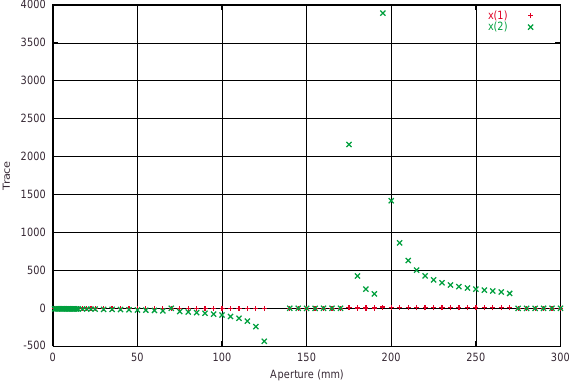
FIG. 3. (Color) First-order and second-order x chromaticities as a function of aperture. The fringe field shape is given by the default Enge